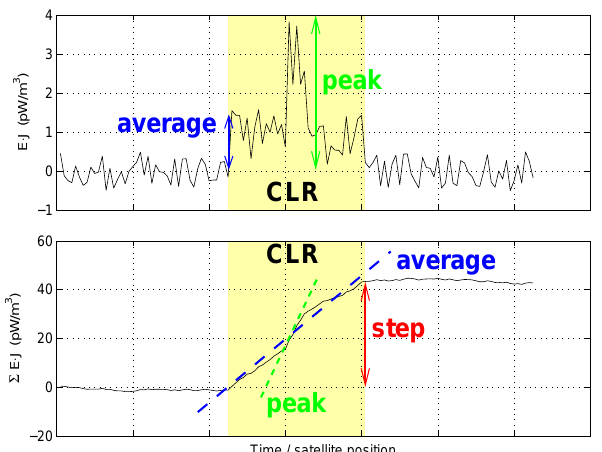
Fig. 1. Schematic CLR (Concentrated Load Region) observed in the power density data. The top panel shows the power density. The bottom panel contains the time integral of the power density along the satellite path. The quantities peak and average correspond to the maximum and average value of the time series of the power density, and hence the maximum and average slope in the integrated power density. The step size measures the increase in the integral. The CLR is highlighted in yellow and it is identified as a clear and con- centrated region of E · J > 0 in the top panel and a positive step in the integrated power density in the bottom panel. A CGR (Concen- trated Generator Region) behaves similarly, although E · J < 0 and the integrated power density instead shows a